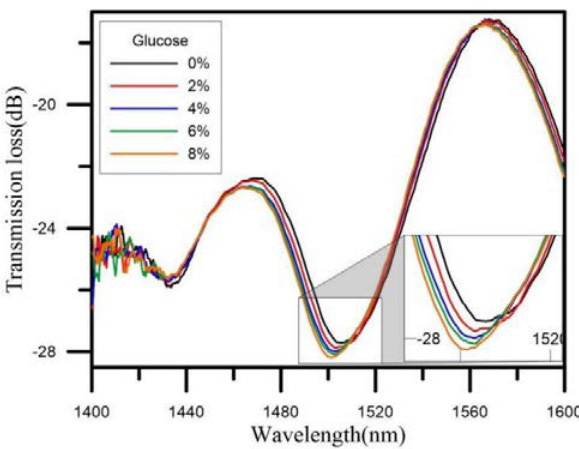
Figure 14. Wavelength change at concentrations of 0–8% glucose in water [23].